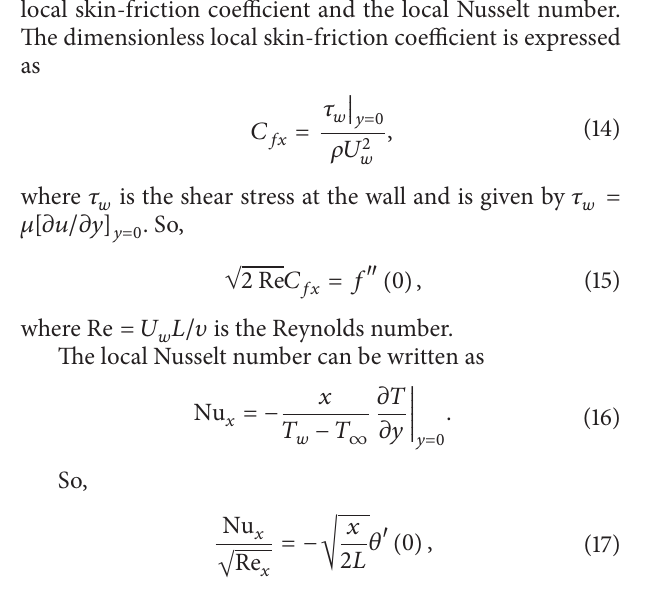
along the sheet, 𝐿 denotes the reference length, and 𝜆 is a parameter which is physically very important in controlling the exponential increment of temperature along the sheet and it may have both positive and negative values. The stretching and free stream velocities 𝑈 𝑤 and 𝑈 ∞ are, respectively, given by